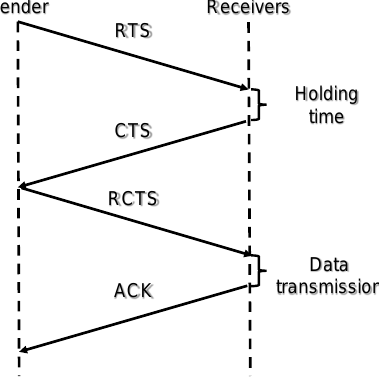
Figure 2. Handshake